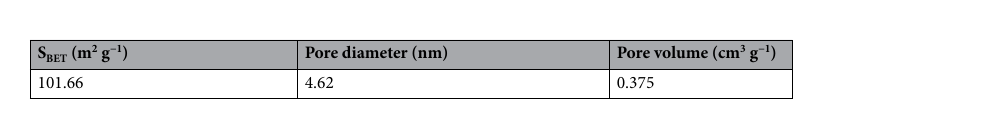
Table 2. Textural properties of Cu(II)-MP-bis(AMP)@boehmite.